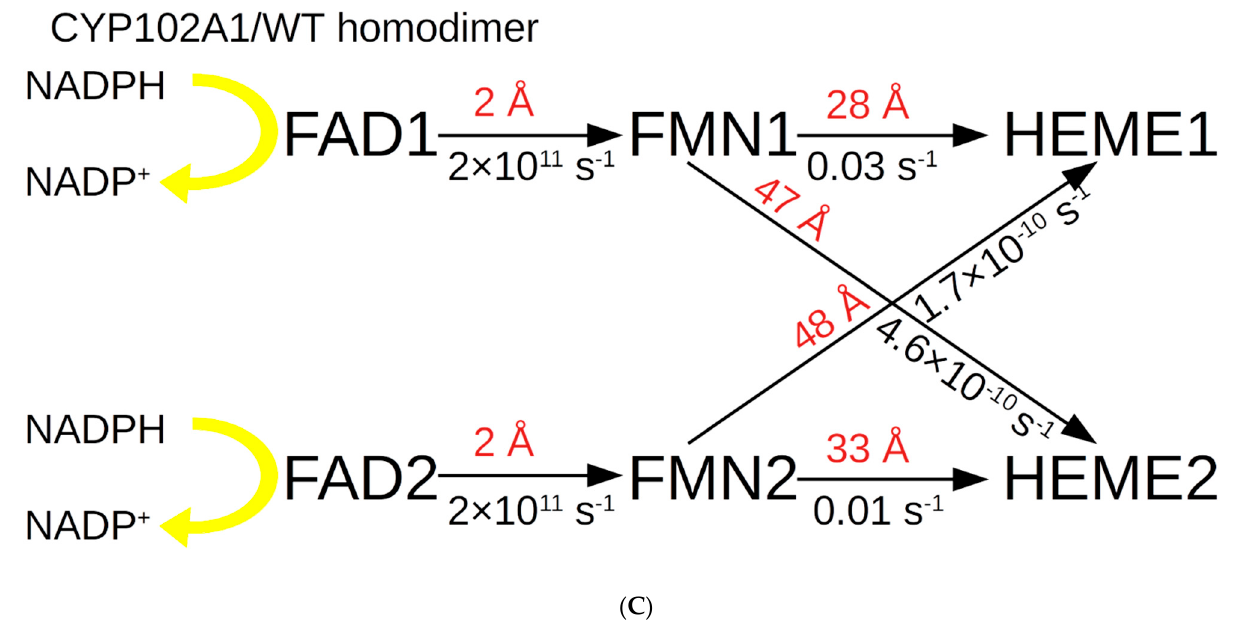
Figure 2. ( A ) Spatial structure of CYP102A1/WT homodimer, where ( A , B ) are two planes (( B ) ro- tated relative to ( A ) 90 degrees down the horizontal axis) of the structure obtained in AFMultimer. Each of the domains is shown in colour: heme (cyan and blue), FMN (yellow and grey), FAD (orange and magenta). ( C ) Schematic diagram of electron transport in the electron transport chain of CYP102A1/WT monomer.